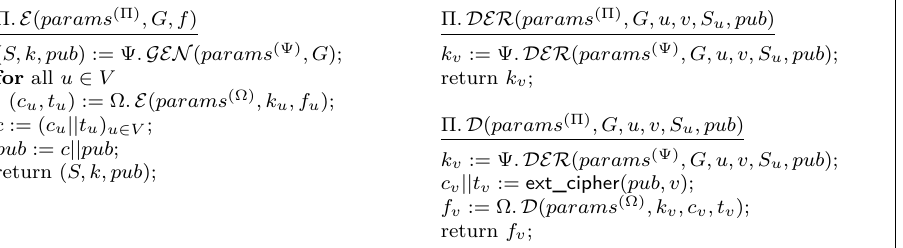
Figure 7: Algorithmic description of the KAS-AE scheme of Subsection 4.1: simple combination of KAS and AE